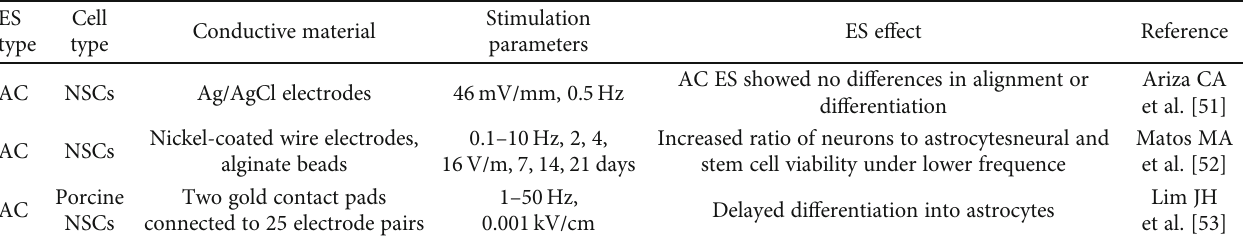
Table 3: Alternating current stimulation used in stem cell neural di ff